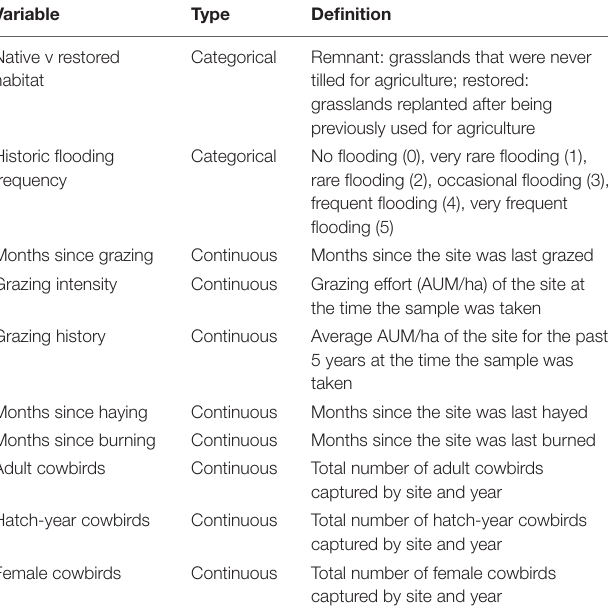
TABLE 2 | Land management, habitat, and cowbird